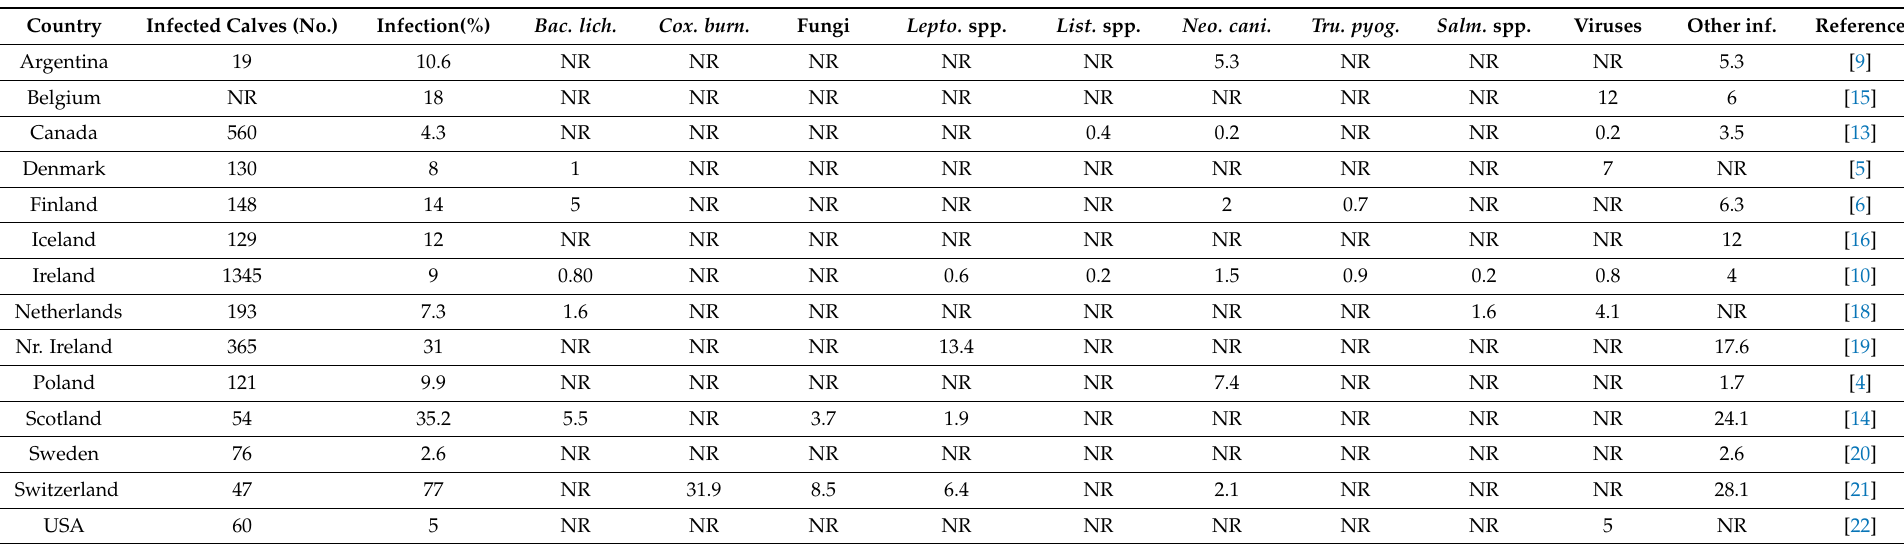
Table 3. Distribution of pathogens (antigens) detected in calves dying in the perinatal period (0–48 h) internationally (% of dead perinates). Country Infected Calves